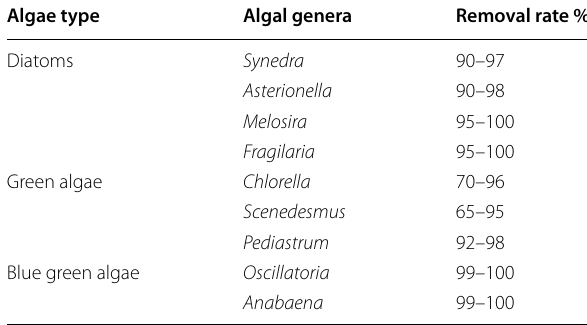
Table 4 Removal rate for algae in sedimentation basin Algae type